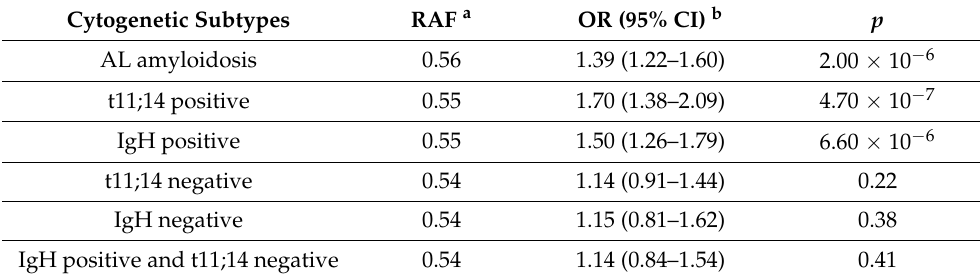
Table 1. Association of SNP rs9344 with AL ( N = 380) overall and by cytogenetic subtype (reference [22]).